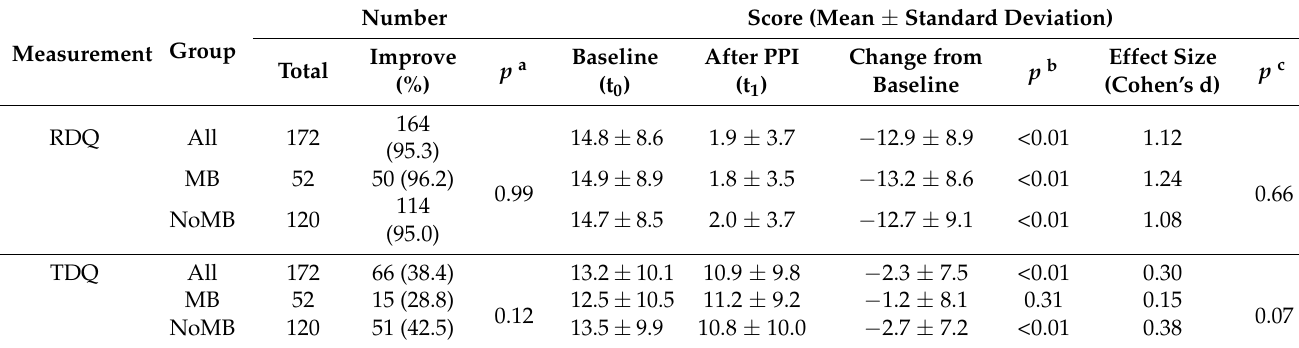
Table 2. Change in the TDQ and RDQ scores of patients with GERD before and after PPI therapy. Number Score (Mean ± Standard Measurement Group